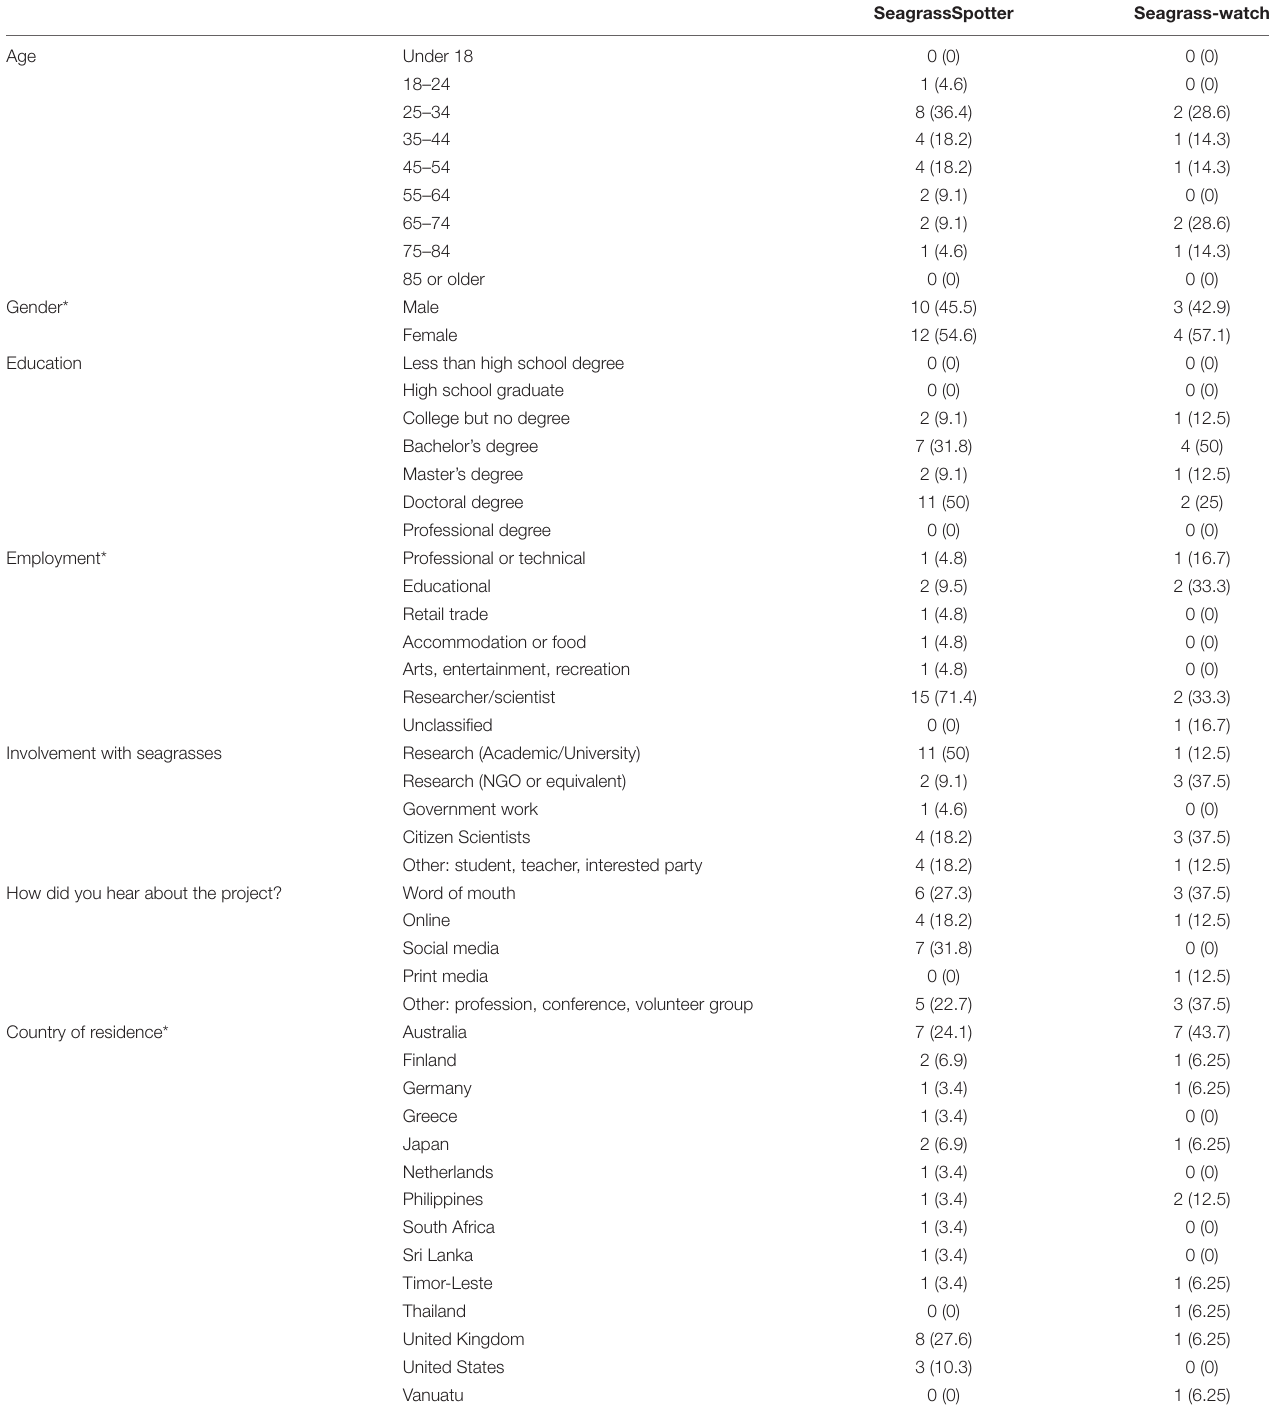
TABLE 2 | Demographics of users of current SeagrassSpotter and Seagrass-Watch users summarised as frequency and valid percent